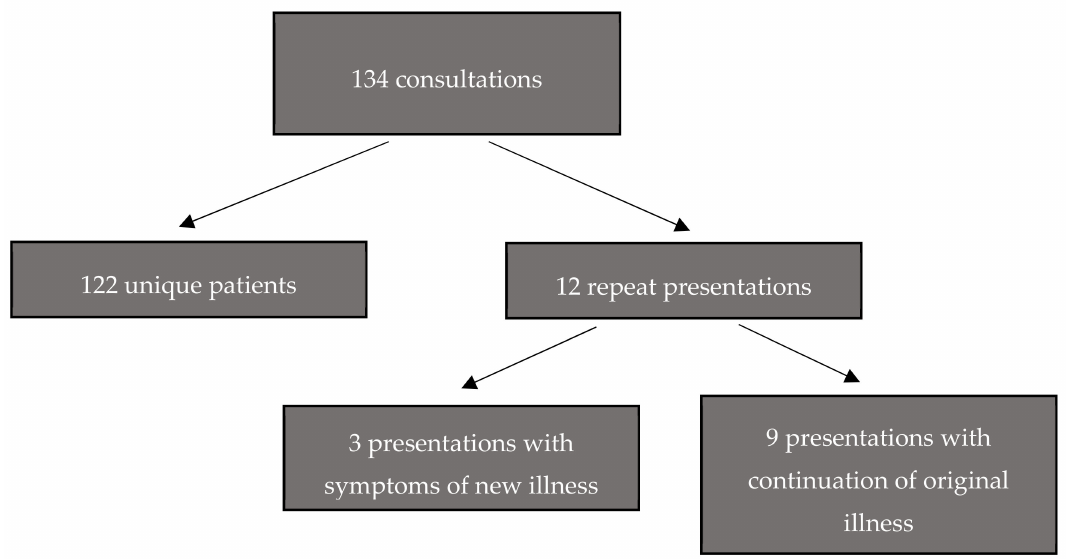
Figure 1. Overview of clinic attendances during the study